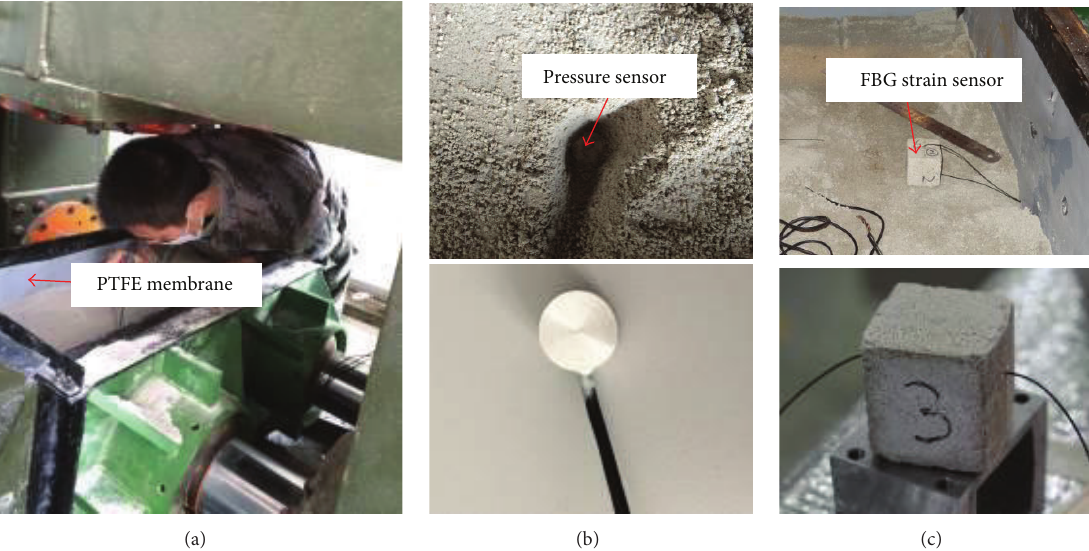
Figure 6: Fiber grating strain (FBG) sensor and pressure sensor embedded process: (a) layered filling of the model; (b) DZ-I pressure sensors; (c) FCC-Y FBG strain